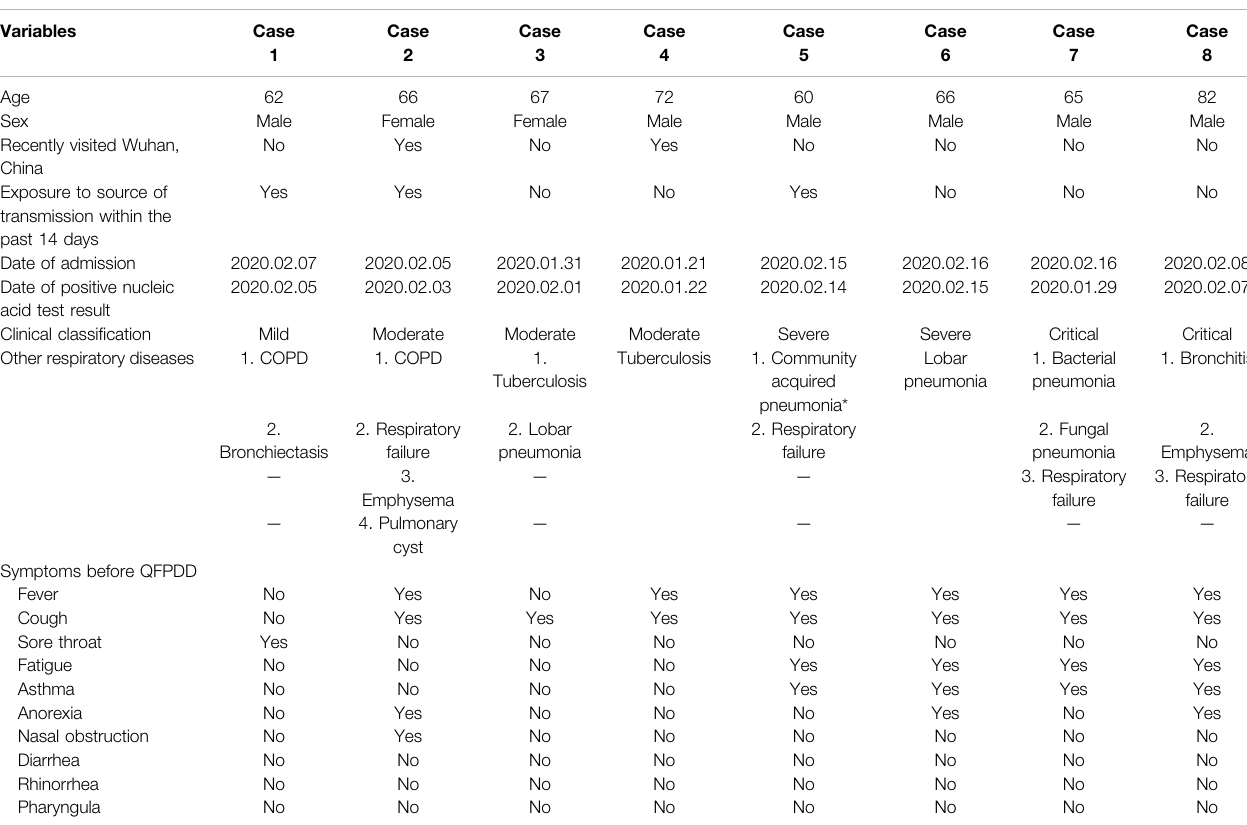
TABLE 2 | Demographics and clinical characteristics of the eight COVID-19 cases with other respiratory diseases.